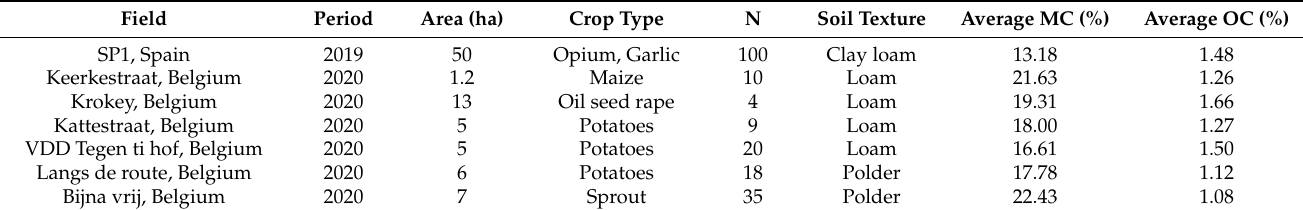
Table 1. Characteristics of the study fields in Spain and Belgium.